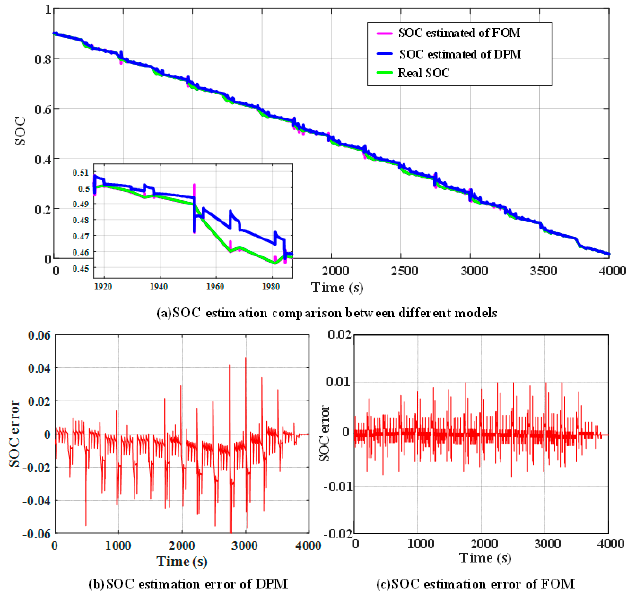
Figure 9. SOC estimation results under the DST test cycle condition.